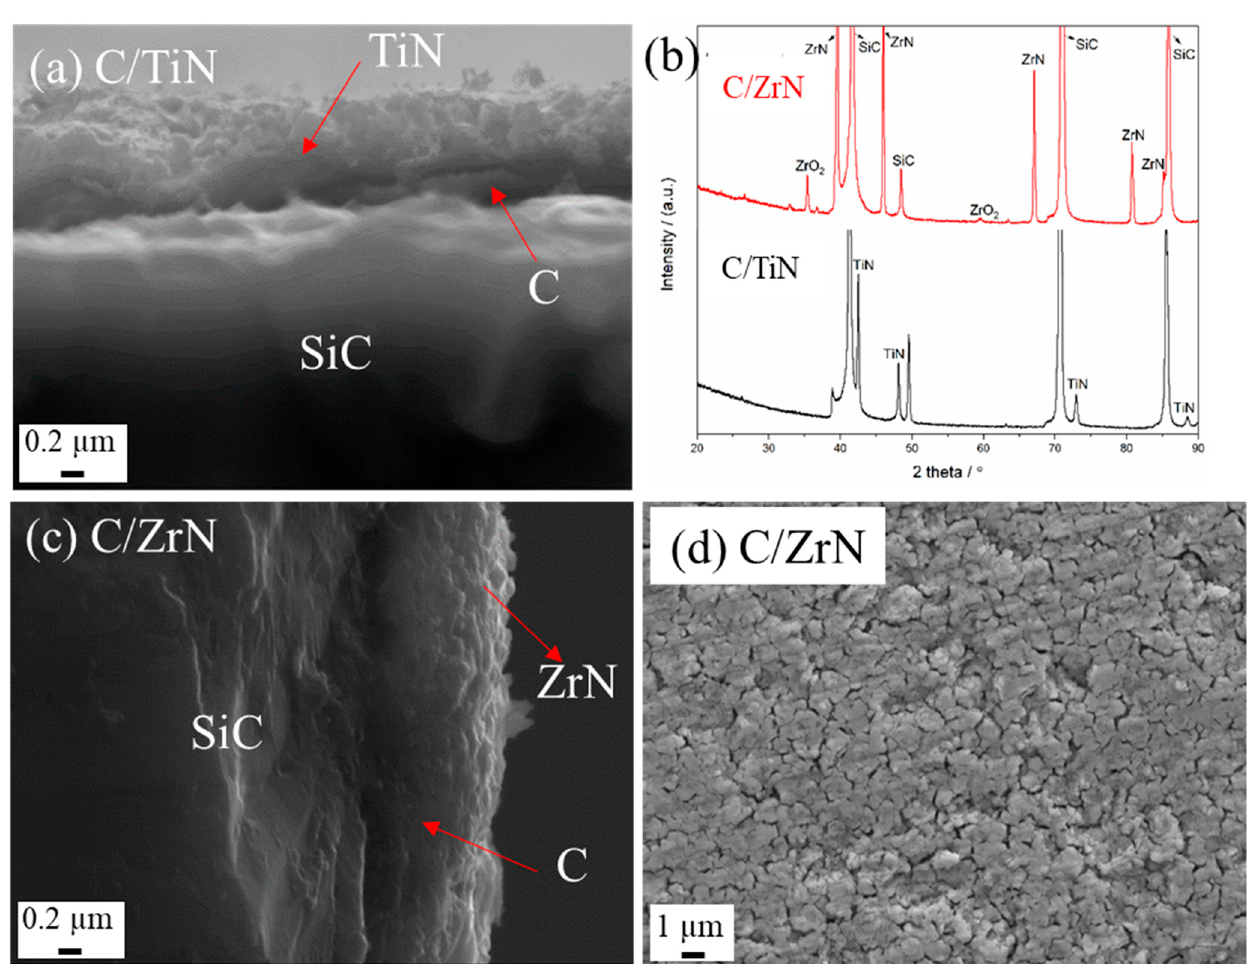
Figure 12. SEM images with SE2 mode of surface and cross-section of sputtered coating and XRD patterns after 1400 °C heat treatment at N 2 atmosphere. ( a ) the cross-sectional image of C/TiN coating; ( b ) XRD patterns of sputtered coating after 1400 °C heat treatment; ( c ) the cross-sectional image of C/ZrN coating; ( d ) the surface of C/ZrN coating.